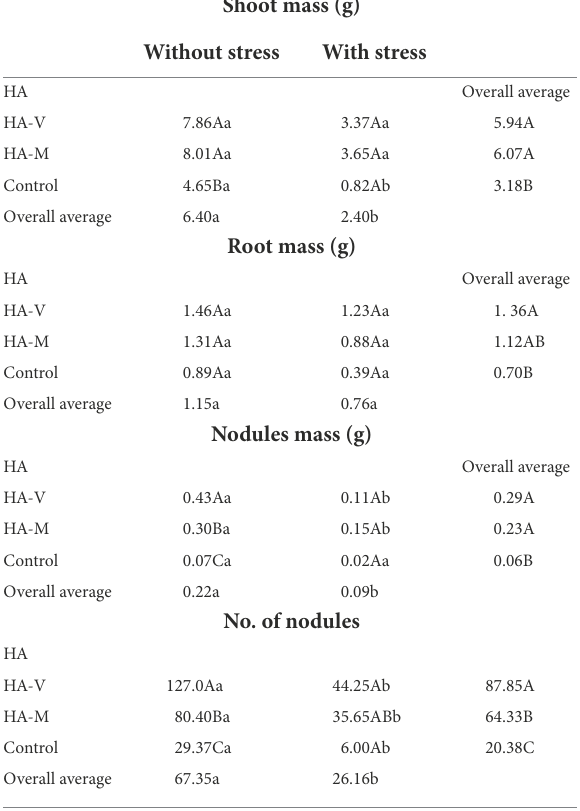
TABLE 1 Soybean plant parameters evaluated under different water